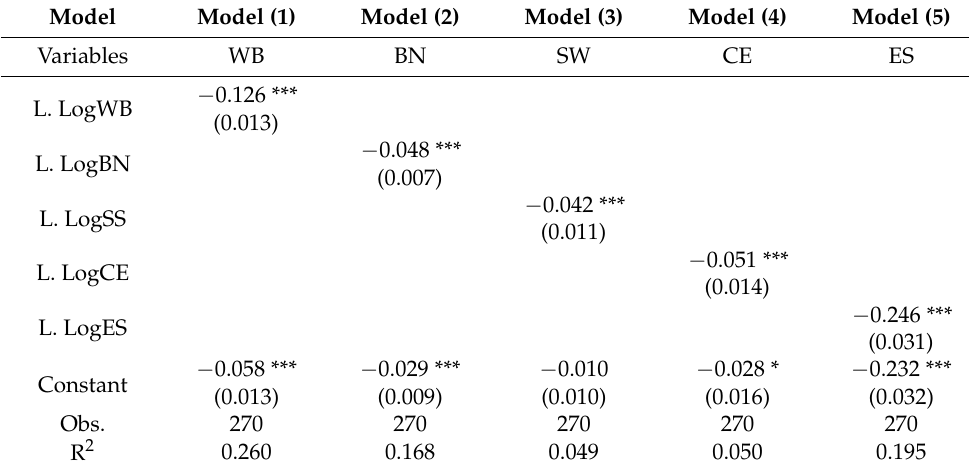
Table 2. Results of absolute β convergence